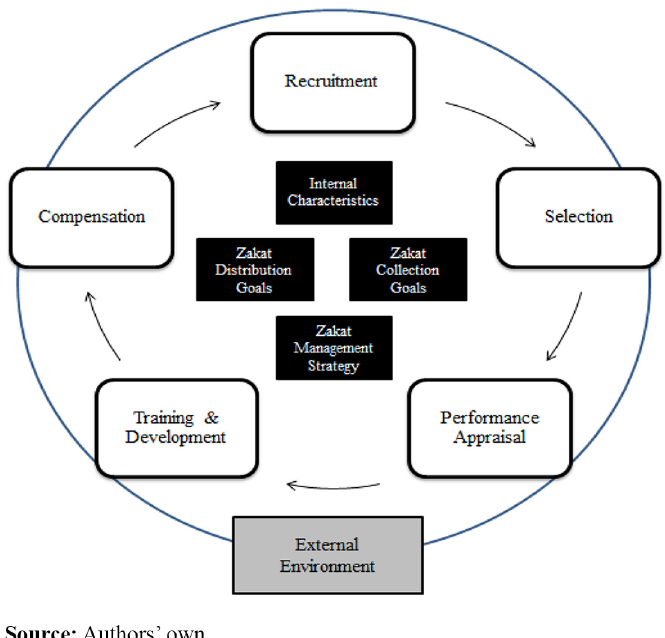
Figure 3. Proposed HRM